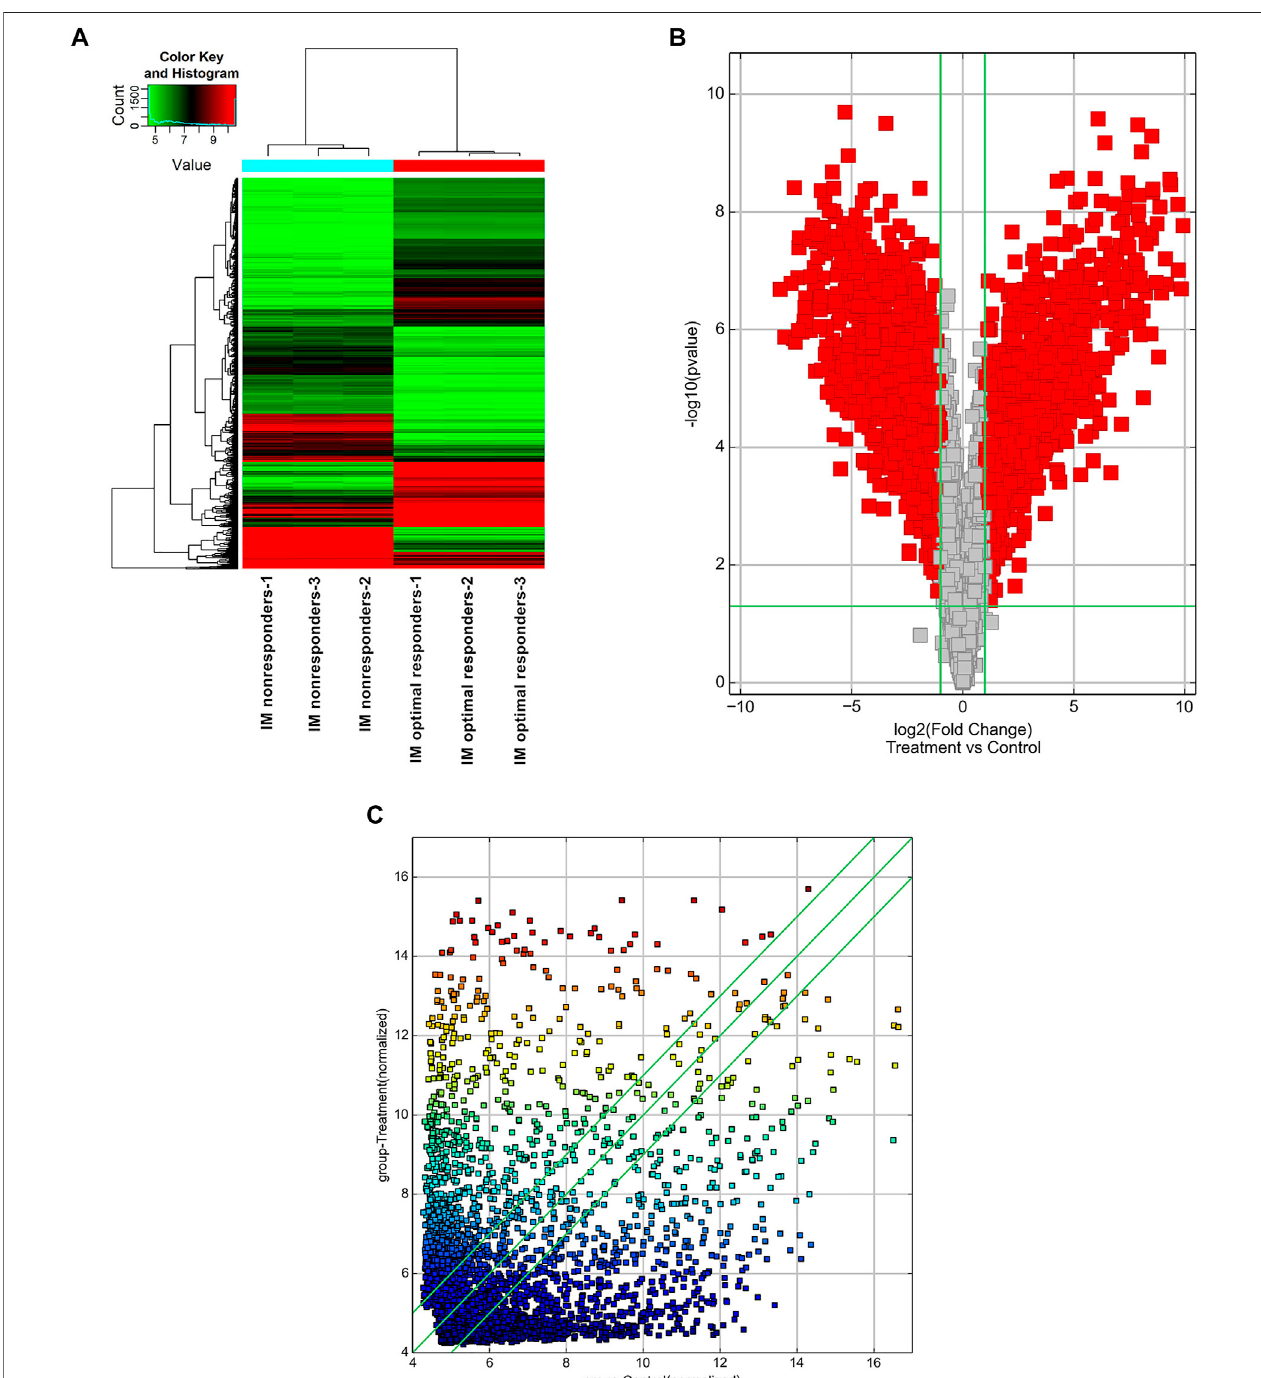
FIGURE 1 | Pro fi ling of circular RNAs in the plasma from CML patients with different clinical responses to imatinib. (A) Heat map shows the upregulated and downregulated circRNAs in IM optimal responders vs IM nonresponders. Each column represents the expression pro fi le of a plasma sample group, and each line corresponds to a circRNA. High expression level is indicated by “ red ” and lower levels by “ green ” . (B) Volcano plot shows the up-regulated and down-regulated circRNAs in IM optimal responders (control) vs IM nonresponders (treatment). The abscissa is the log2 (Fold Change) of the circRNA level difference between samples, the ordinate is -log10 ( p -value). circRNAs having fold changes ≥ 2 and p -values ≤ 0.05 are indicated by “ red ” . (C) Scatter plot shows the up-regulated and down-regulatedcircRNAsinIMoptimalresponders(abscissa,control)vsIMnonresponders(ordinate,treatment).circRNAshavingfoldchanges ≥ 2and p -values ≤ 0.05 are distinguished by line 1 and line